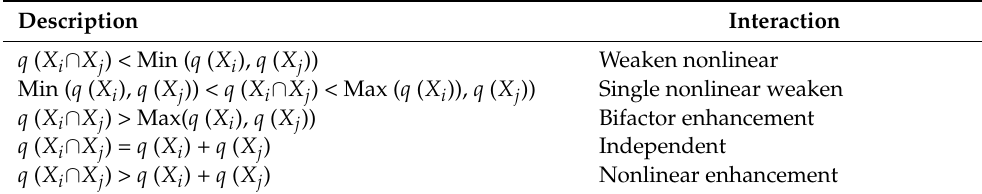
Table 2. Interaction between explanatory variables ( X i and X j